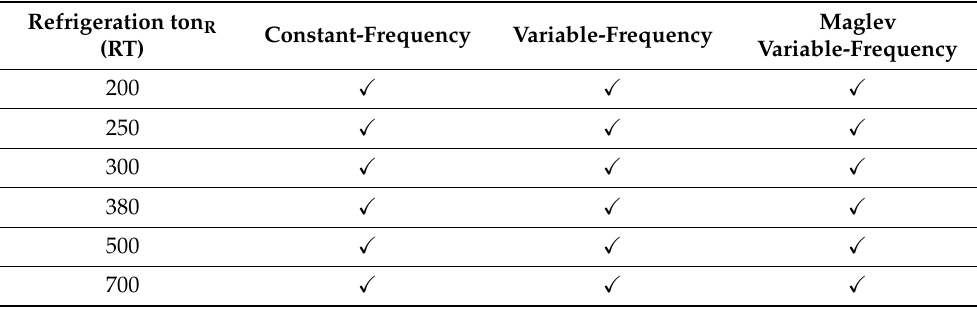
Table 1. Operation mode of centrifugal water chiller for different refrigeration ton R condition settings: fixed- and variable-cooling water.